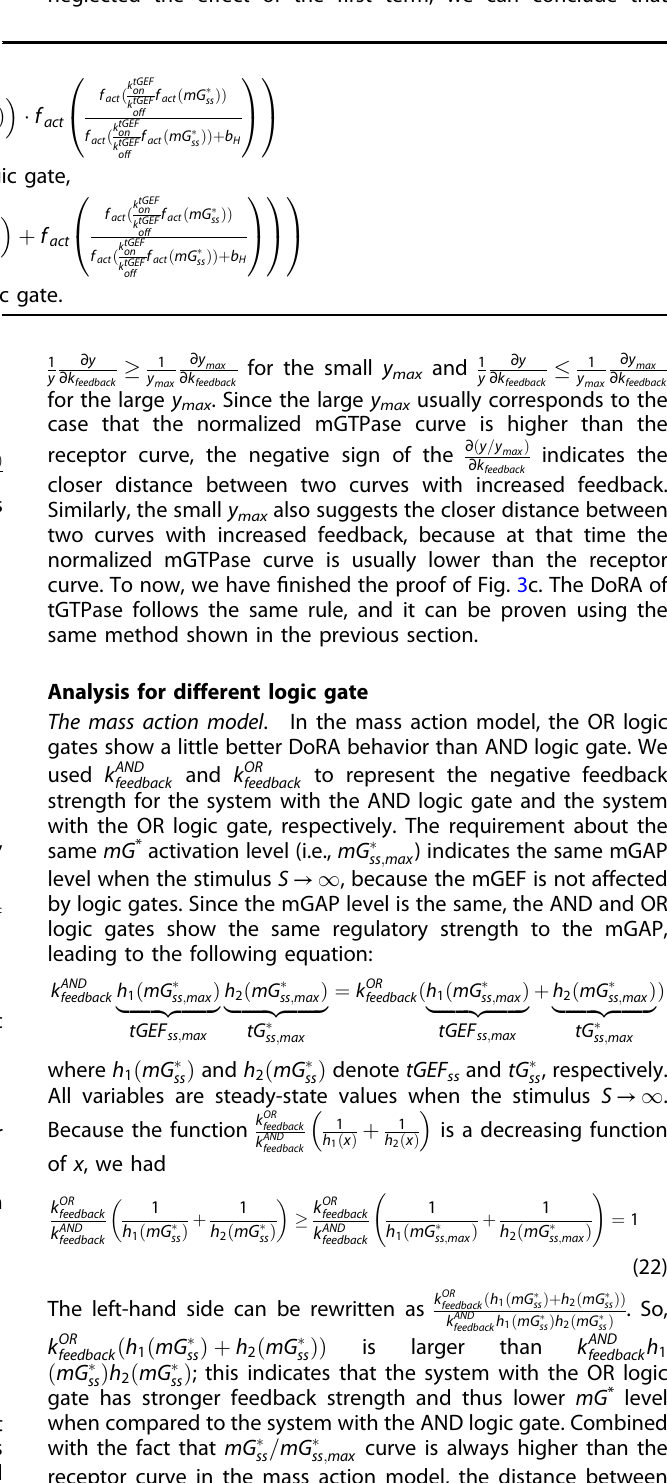
gate has stronger feedback strength and thus lower mG * level when compared to the system with the AND logic gate. Combined = mG (cid:1) with the fact that mG (cid:1) curve is always higher than the ss ss ; max receptor curve in the mass action model, the distance between these two curves in the system with the OR logic gate is smaller than that with AND logic gate (Fig. 4b). This implies the better DoRA performance of the OR logic in the mass action model. However, this advantage is small (See main texts for more explanations).